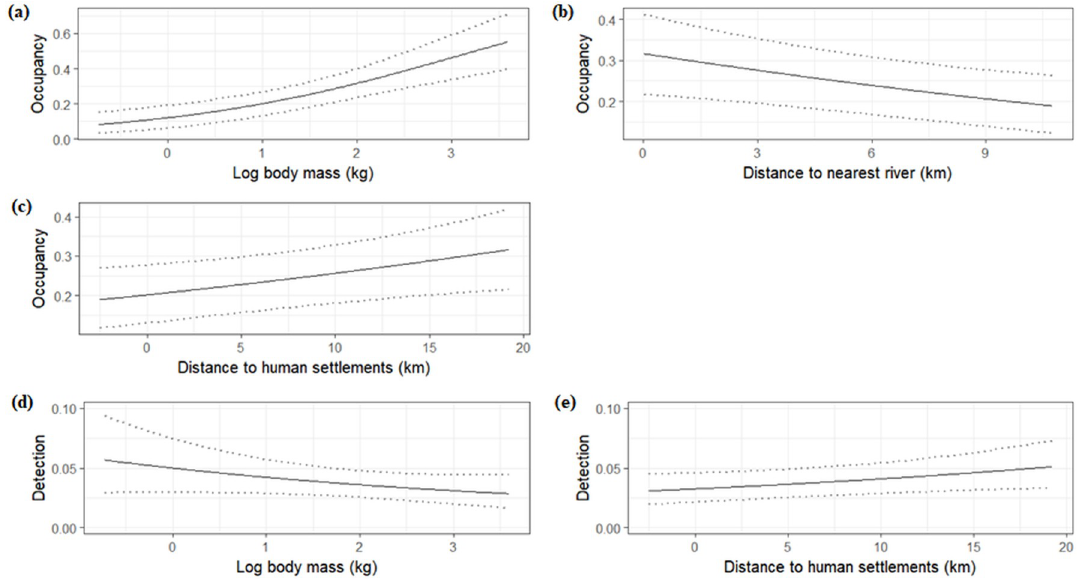
Fig 2. Covariate effects on occupancy and detection at the landscape scale. Mammal meta-community responses of occupancy probability to body mass (a), distance to the nearest river (b) and distance to human settlements (c), and of species detection probability to mass (d) and distance to human settlements (e) in the Udzungwa Mountains of Tanzania.